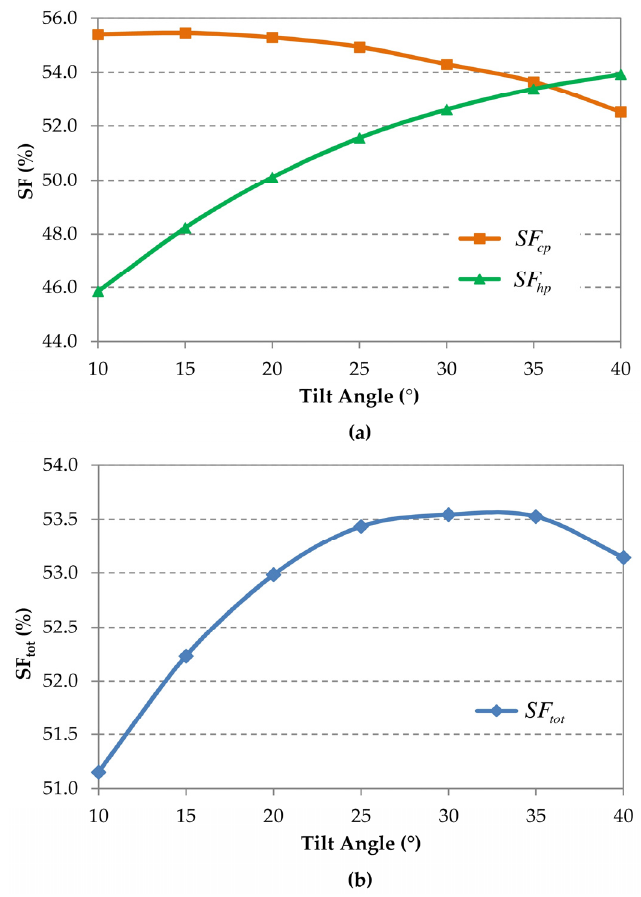
Figure 9. ( a ) Seasonal and ( b ) total solar fractions ( SF s) as a function of tilt angle. Considering the plant optimized with respect to the total SF , the energy flows related to the heating period and those related to the cooling period are listed in the Table 9. Table 9. Heating and cooling operation energy flows.